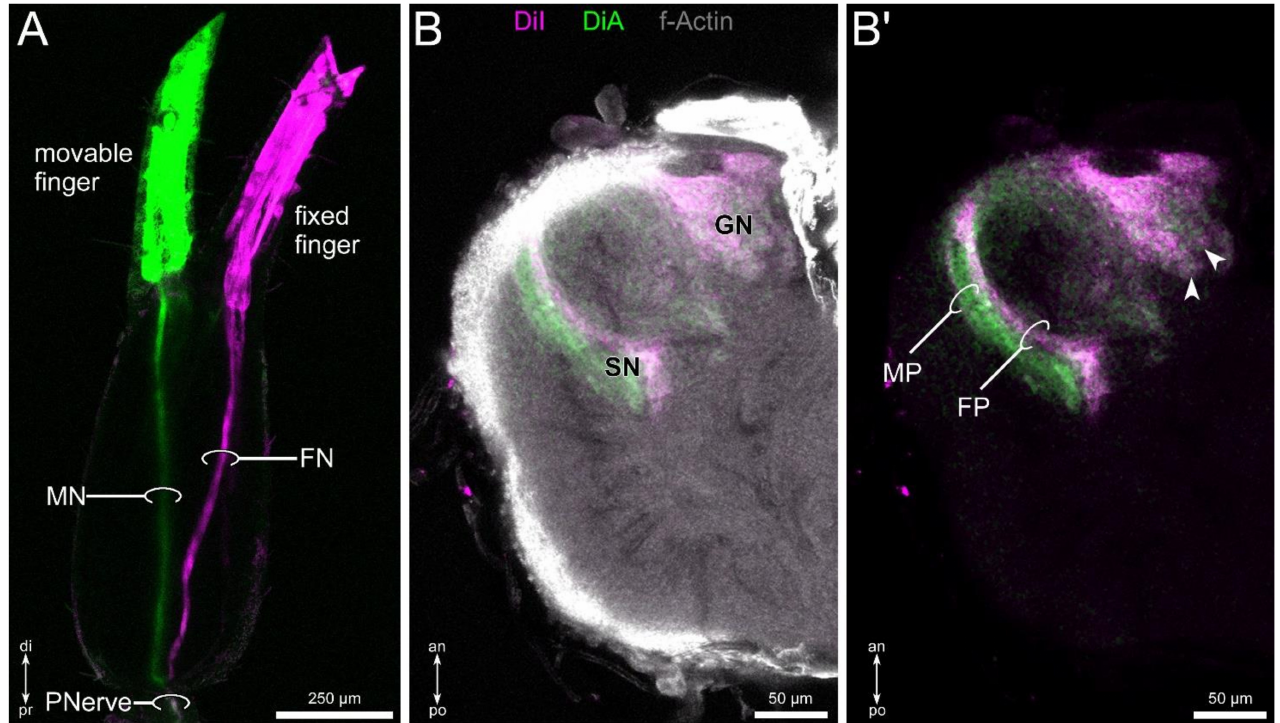
Figure 6. Differential labeling of movable and fixed finger nerves with lipophilic dyes (DiI: magenta; DiA: green), combined with f-actin labeling (gray). ( A ) Overview of dye-injected fingers, visualizing the projection pattern of the fixed finger (FN) and movable finger nerve (MN). At the chela–patella joint, both fibers fuse (pedipalpal nerve: PNerve). ( B , B’ ) Horizontal view, showing the innervation pattern of the glomerular neuropil (GN) and the stratified neuropil (SN). While the GN is inner- vated homogenously (arrows point to selected glomeruli), the stratified neuropil shows a distinct innervation pattern by fibers associated with the movable finger (movable finger portion: MP) and fixed finger (fixed finger portion: FP). Other abbreviations: an: anterior; di: distal; po: posterior; pr: